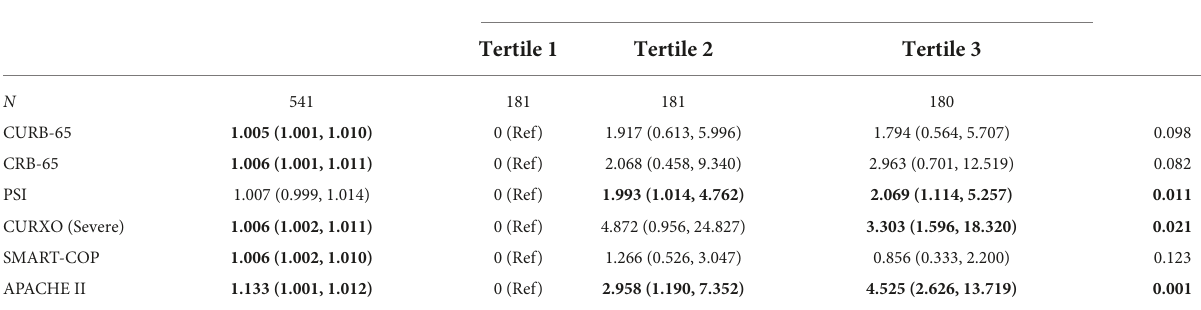
TABLE 2 Associations between serum CYR61 and CAP severity